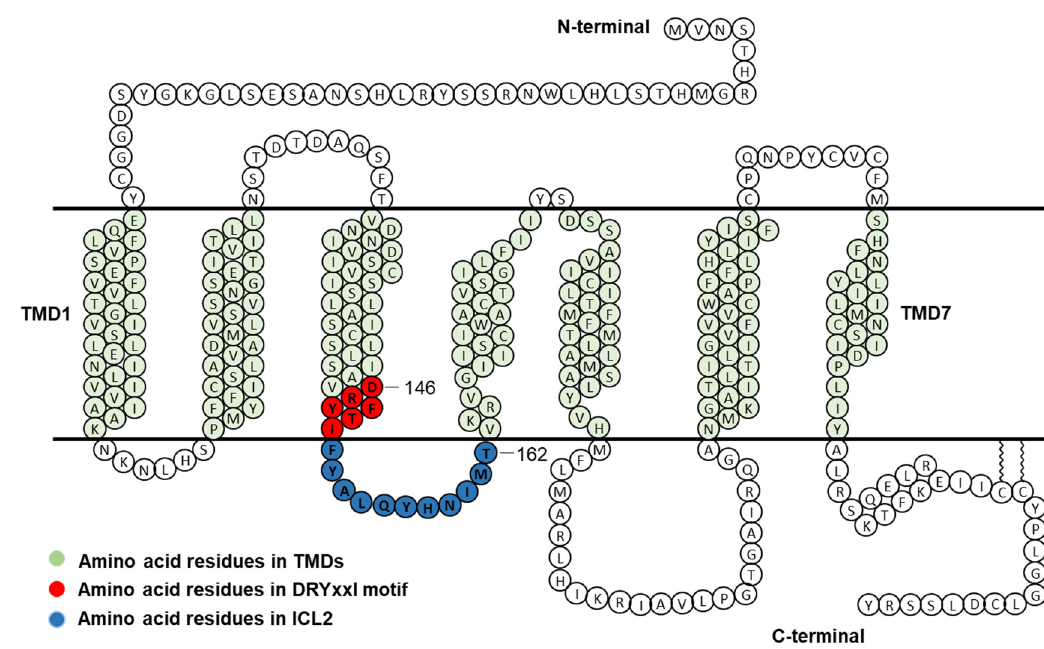
Figure 1. Schematic model of human MC4R. Amino acid residues in DRYxxI motif and ICL2 are indicated in red and blue circles, respectively. TMD, transmembrane domain; ICL2, intracellular loop 2.